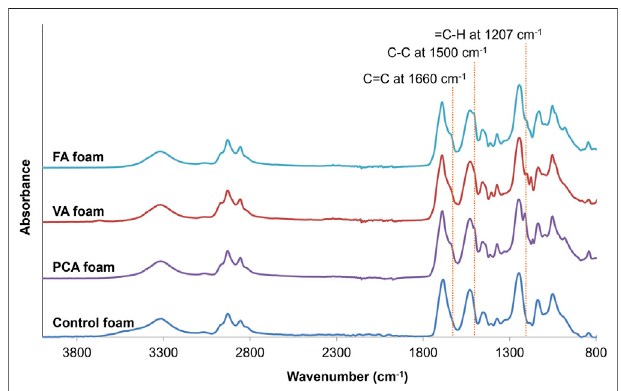
FIGURE 2 | FTIR spectra of synthesized PCA, VA, FA, and control foams. Incorporation of PCA, FA, and VA into SMP foams resulted in the addition of a C=C peak at ~1,660 cm − 1 , a C-C peak at ~1,500 cm − 1 , and a = C-H peak at ~1,207 cm − 1 , corresponding to the phenolic ring of the PAs. These key peaks are highlighted with dotted